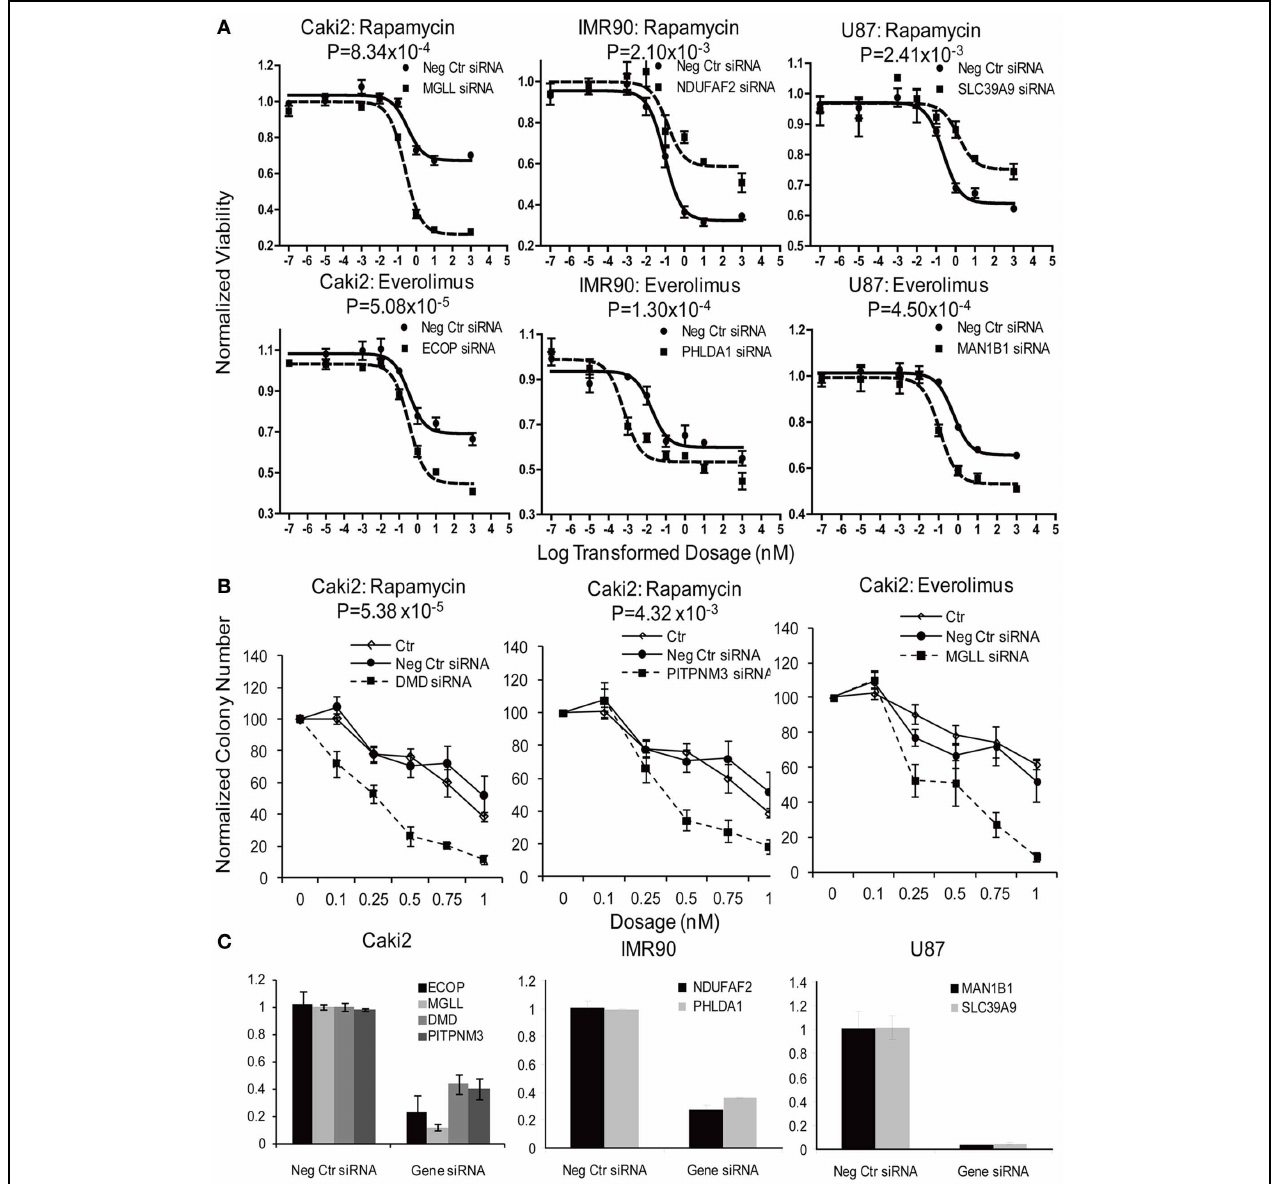
FIGURE 4 | Functional validation of candidate genes with siRNA knockdown in IMR90, U87 and Caki2 cell lines, followed by cytotoxicity assay (A) and colony formation assays (B). Data shown are representative experiments for selected genes in each cell line. siRNA knockdown for each individual gene (dashed line) were compared with negative control siRNA